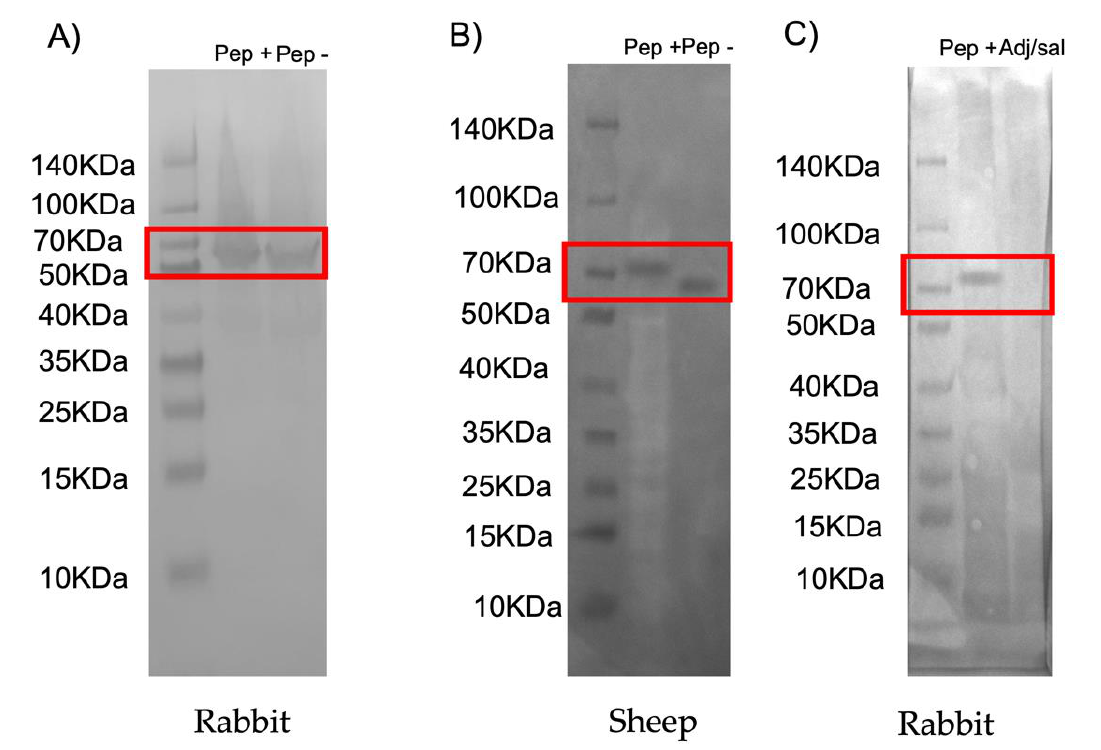
Figure 2. Production of the recombinant proteins and antibody detection of the chimeric proteins by IgG antibodies produced in sheep and rabbit previously immunized with MSP1a and the chi- meric protein. Samples equivalent to 10 µg of total proteins were loaded on a 12% polyacrylamide gel and for Western blot analysis, proteins were transferred to a nitrocellulose membrane. ( A ) A Western blot was performed using IgG antibodies from rabbits immunized with recombinant MSP1a antigen in order to confirm the size of the chimeric MSP4 antigens. Peptide + (AA- VCACSLLISGSSFAYSGNNDASDVSGVMNGSFY-NKNLSTLNVSDPASFTQHDPSFK- FAKSLLTSFDGATGYAIGGARV-KIDSVKDISVMLNAC-LIAGGSYHGIFDEQYA) is the chimeric antigen that contained the epitopes or regions that showed protection against A. phagocytophilum in